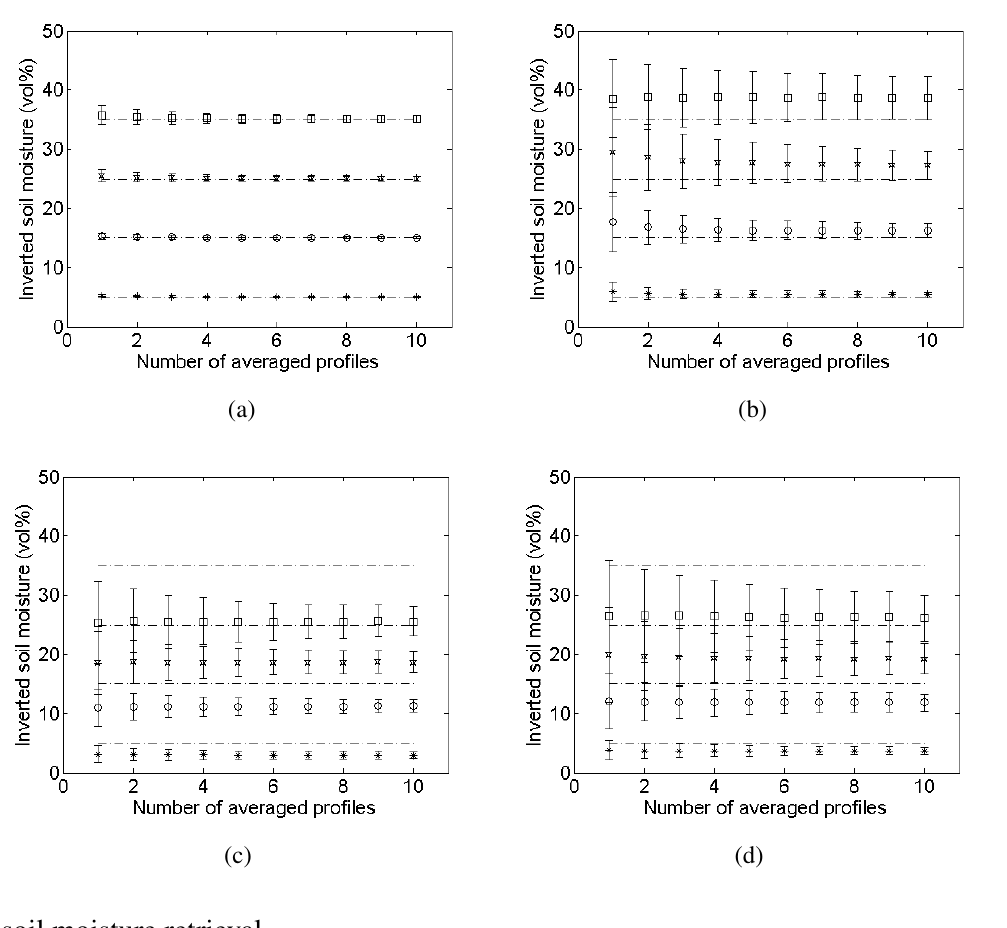
Figure 9. Mean and standard deviations of inverted soil moisture contents for different num- bers of profiles used. Inverted soil moisture contents are derived using roughness parameter series from sampled 4-m profiles, originating from large profiles with ( s , l ) equal to (a), (b) (1 cm,5 cm) and (c), (d) (1 cm,40 cm), and for (a), (c) ASAR VV and (b), (d) PALSAR HH. Considered initial moisture contents are 5 vol% (crosses), 15 vol% (circles), 25 vol% (stars) and 35 vol%